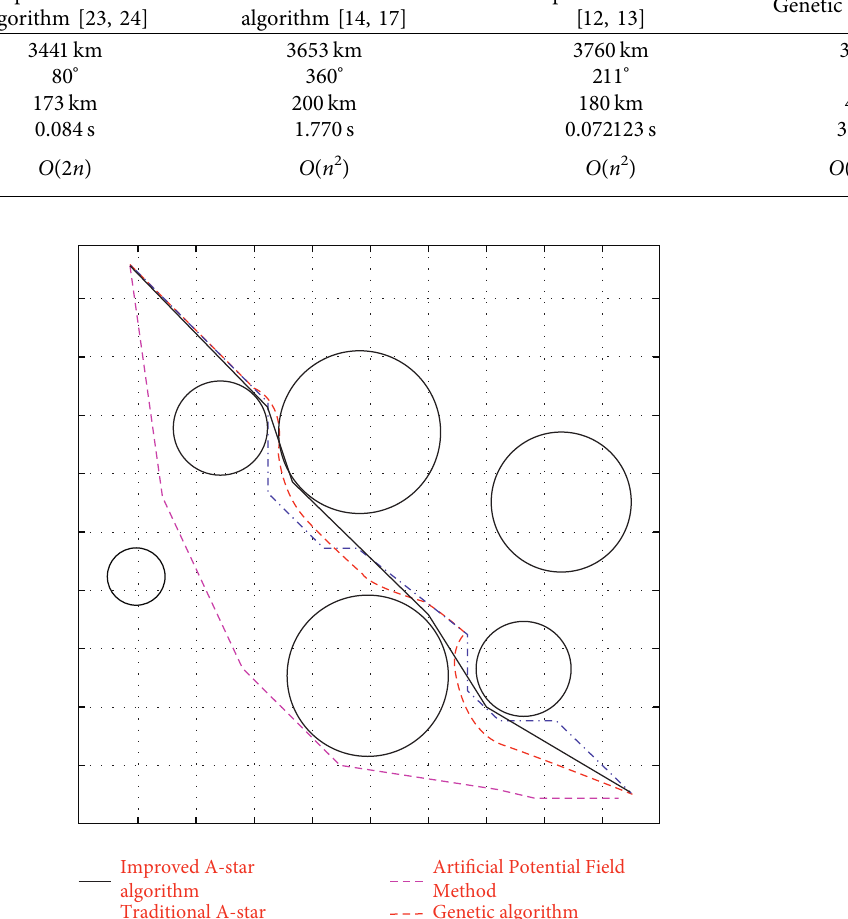
Figure 19: The results of path planning from Madrid to Cairo. Table 7: The results of path planning from Algiers to Rome. Improved A-star algorithm Algorithm category [23,